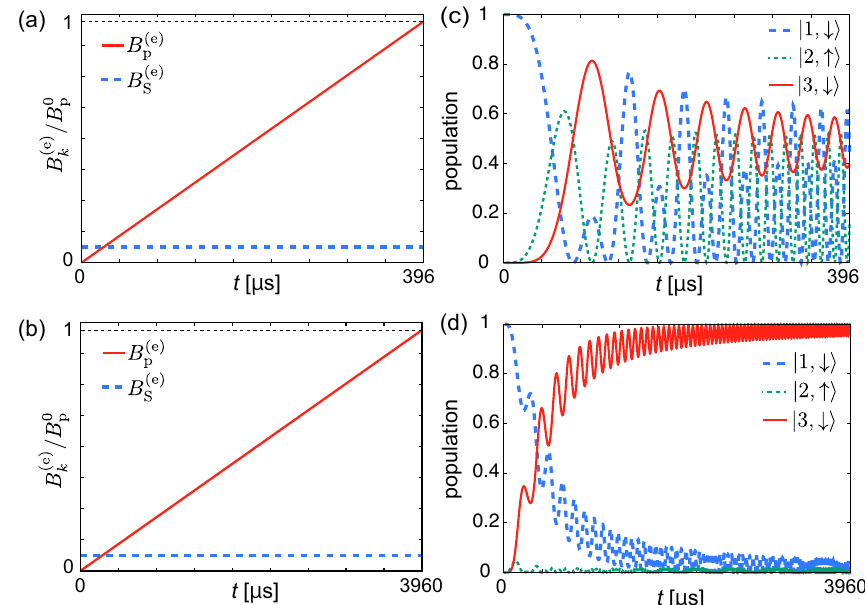
( e ) Figure 5. Envelope functions B for k = p,S normalized by B 0 p for STIRAP with ( a ) T stepI = 396 µ s and k ( b ) T stepI = 3960 µ s. B 0 p is the maximum amplitude of the pump field. The thin dotted line represents 1. Panels ( c , d ) are for the time dependencies of the populations corresponding to the envelope functions in the left